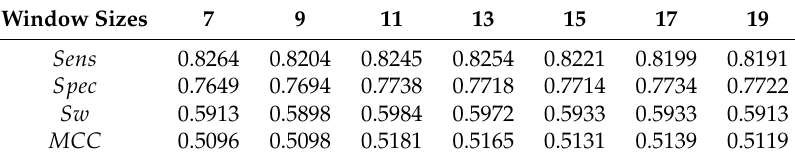
Figure 3. Performance with different long windows. Table 2. Performance with different short windows.